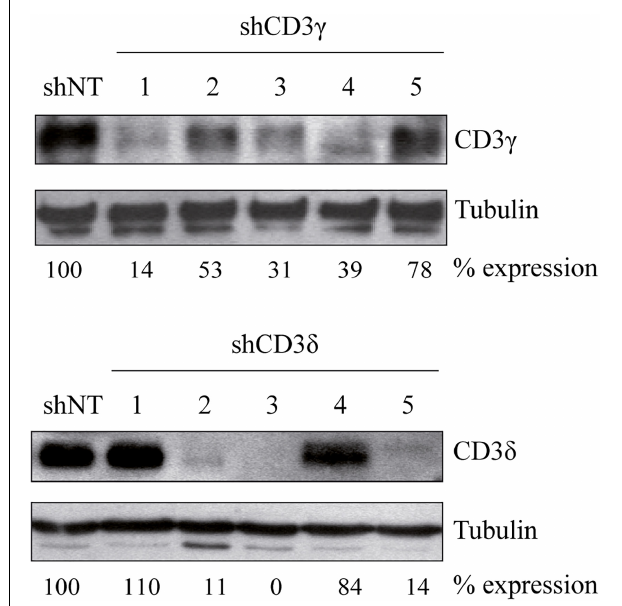
FIGURE 1 | Generation of CD3G or CD3D KD T-cell lines. Jurkat E6-1 cells were transduced with five different shRNA for CD3 γ or CD3 δ and one non-target shRNA (shNT). Cells were lysed in NP-40 buffer after 7 days in culture and 40 µ g of total protein was loaded. Membranes were incubated with antibodies against alpha tubulin (Sigma), CD3 γ (Santa Cruz Biotechnology), or CD3 δ (Santa Cruz Biotechnology). Numbers below each panel indicate the percentage of each chain expression relative to shNT normalized to the loading control (tubulin).